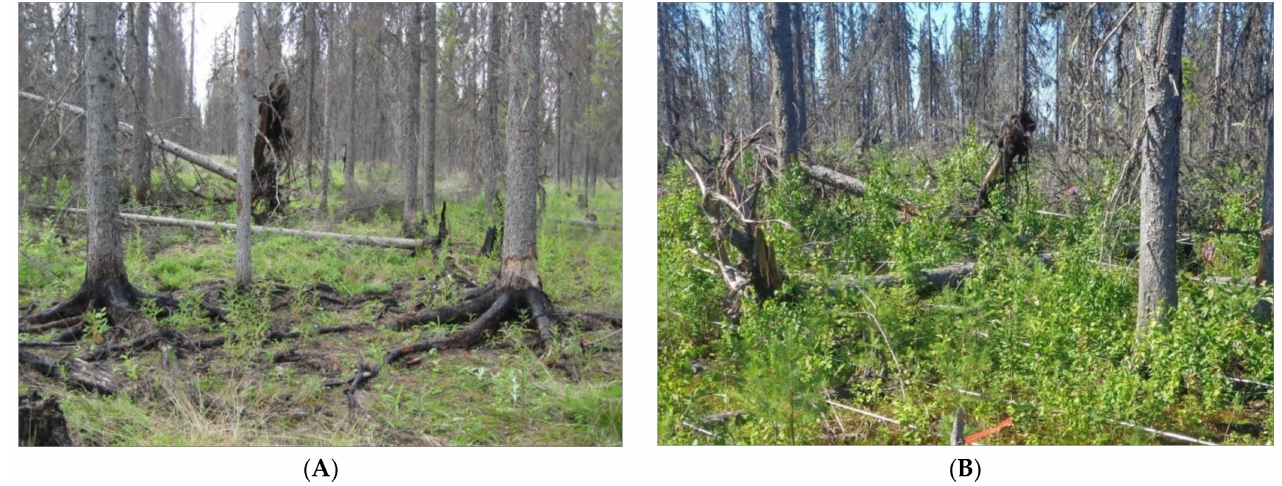
Figure 3. Studied spruce forest burnt by medium-severity fire in SP 8 in 2014 ( A ) and in 2020 ( B ). The stand in SP 9 was affected by high-severity fire. The root systems of spruce trees were heavily damaged because of 100% forest floor reduction and 3 years after the fire all spruce had died back, but 78% of the volume still remained standing by 2014 (Figure 4A); downed deadwood cover was 6.0%. In 2020, 32% of the spruce volume in this plot remained as dead standing trees while the rest of spruce was uprooted (Figure 4B). The cover of downed deadwood was